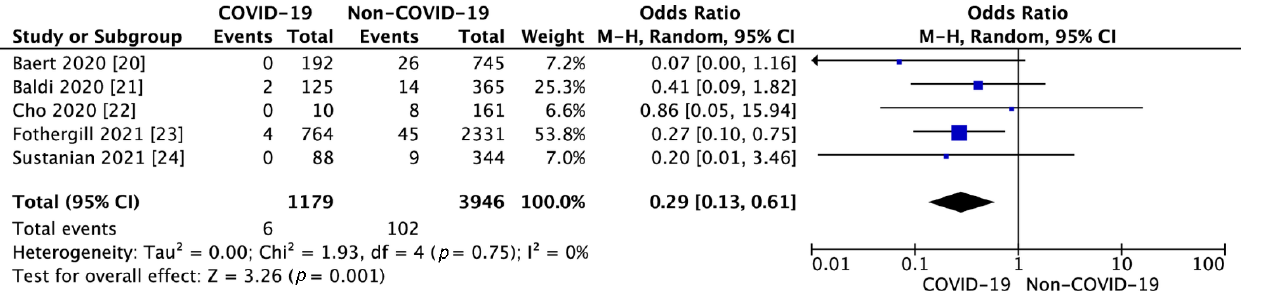
Figure 2. Forest plot of survival to hospital discharge in COVID-19 and non-COVID-19 group. The center of each square represents the weighted odds ratios for individual trials, and the corresponding horizontal line stands for a 95% confidence interval. The diamonds represent pooled results.